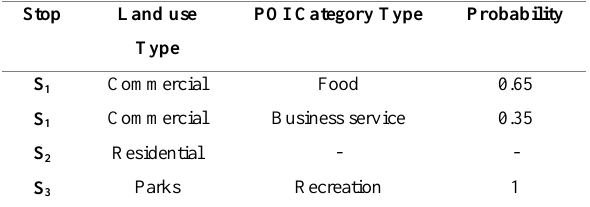
Figure 11. Number of POI types assigned to stop trajectories.